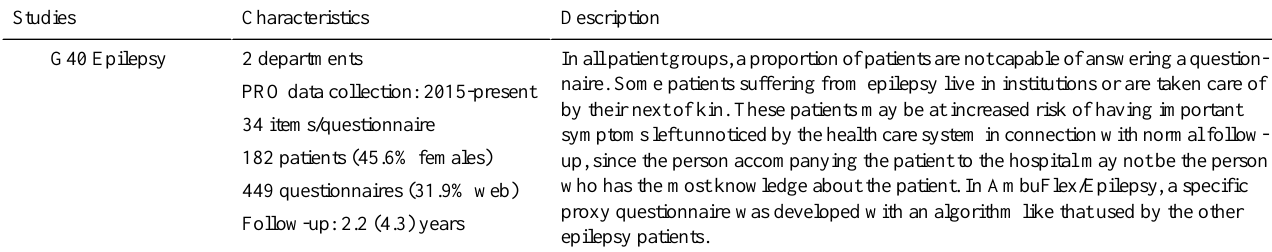
MFI: Multidimensional fatigue inventory. d